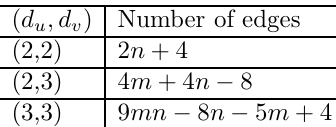
Table 2. The number of three types of edges of the graph T